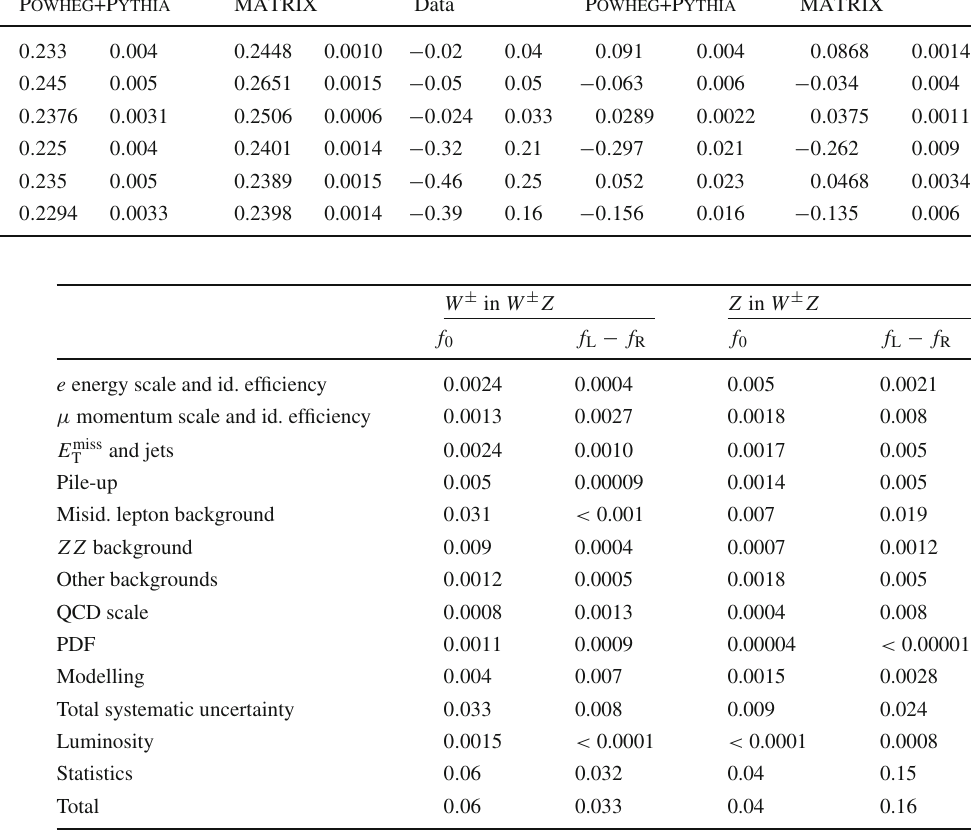
Table 5 Measured helicity fractions in the fiducial phase space with Born-level leptons, for W ± Z W + Z and W − Z events. The total uncer- tainties in the measurements are reported. The measurements are com- pared with predictions at electroweak LO from Powheg+Pythia and